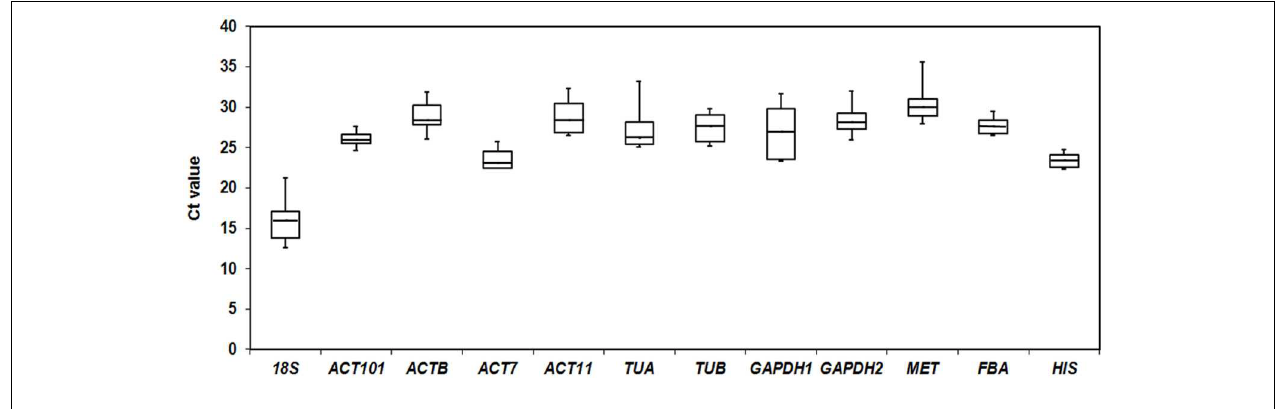
FIGURE 1 | Cycle threshold (Ct) values of 12 candidate reference genes across all samples. The final Ct value of each sample was the mean of three biological and technical replicates. Box graph